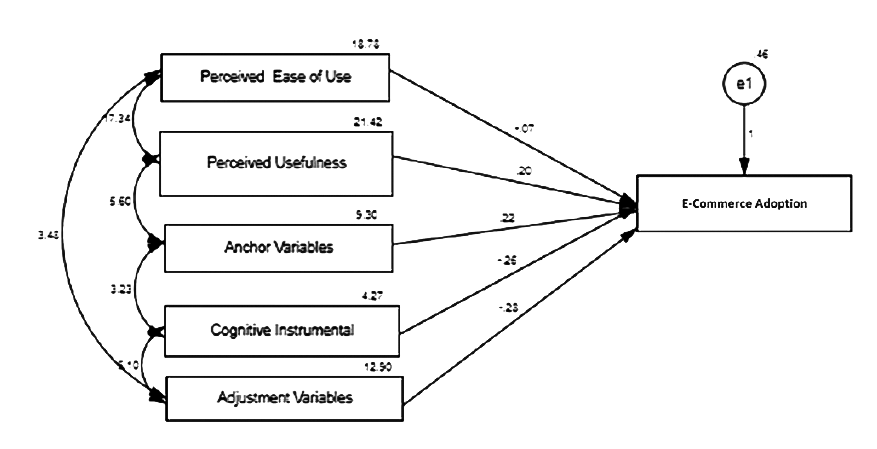
Figure 2. Unstandardized estimates model